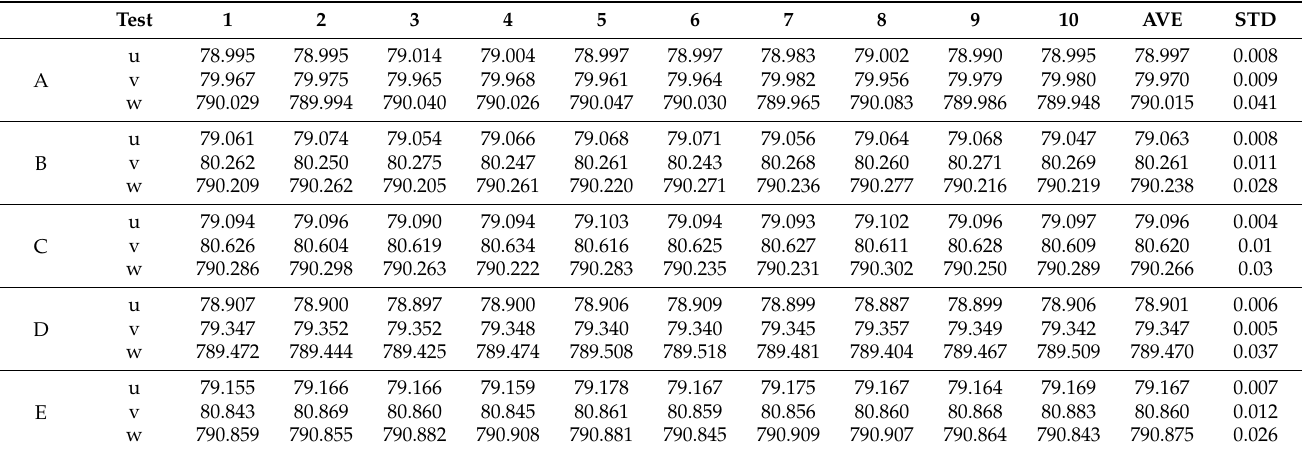
Table 2. Single-point repeatability